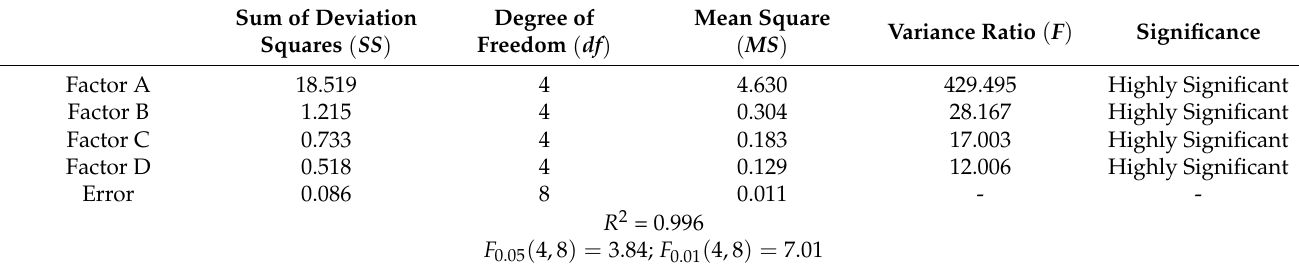
Table 7. ANOVA of room energy